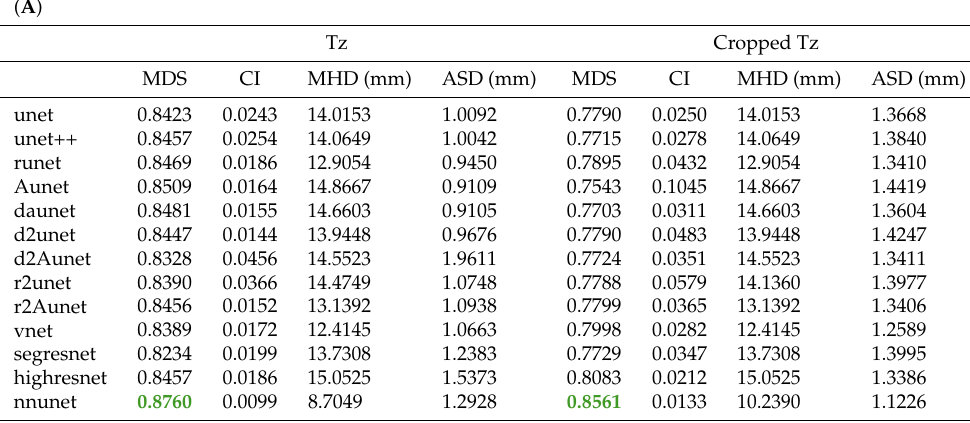
Table 2. ( A ) Results obtained on the external test set by the segmentation models trained on the transitional zone segmentation task. The results presented are the mean scores of the 5-fold models over all the samples on the external test set. The best results (based on Table A2) for both the full and cropped volumes are presented in green. ( B ) Results obtained by the segmentation models on transitional zone segmentation task. The results presented are the mean scores from the validation data over the five folds. The best results for both the full and cropped volumes are presented in red.